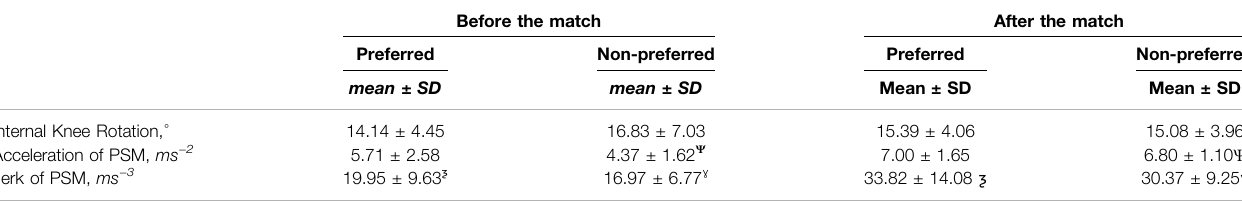
TABLE 2 | Results of the study.